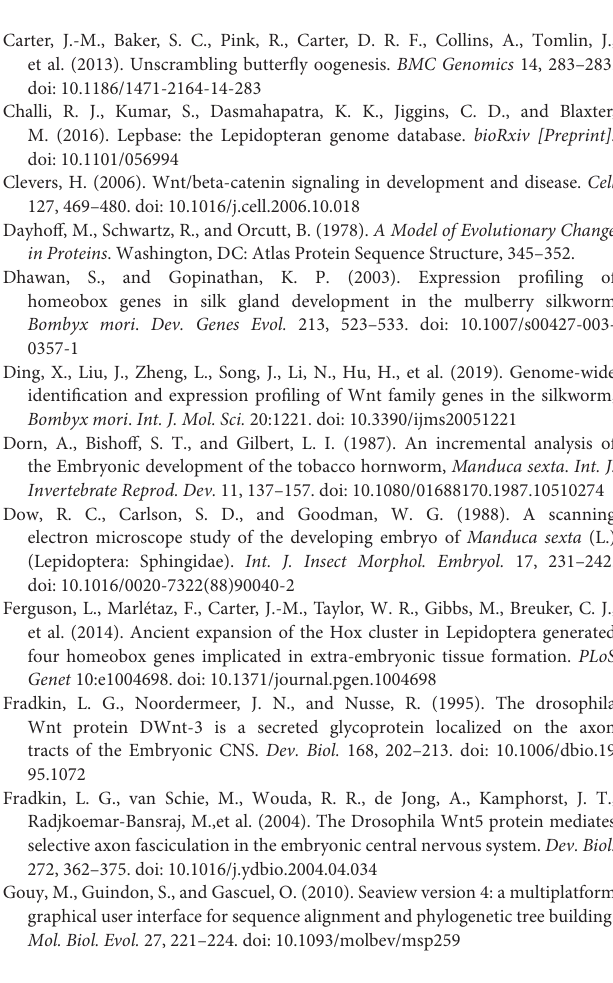
Supplement Table S1 | Protein accession numbers for all used sequences in this study. Supplement Table S2 | Primer sequences for all Wnt probes used in this study. Capital letters show the gene specific sequence, small letters are T7 overhangs used for the cloning method of the